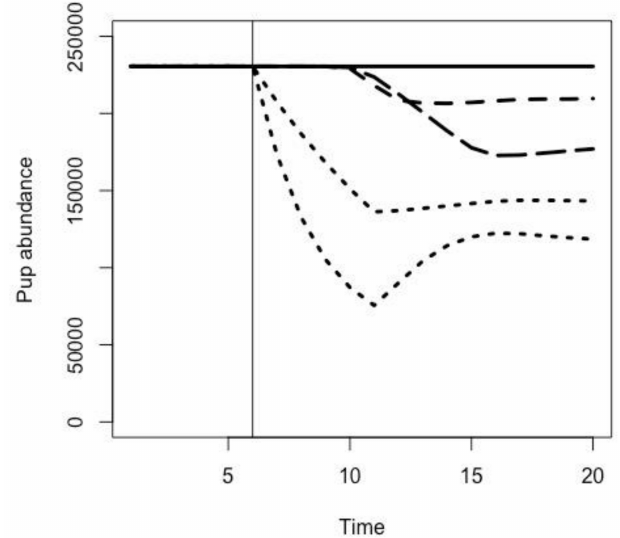
Figure 3. Hypothetical pup abundance projections over a 20-year period under different manipu- lations of Lander’s Leslie matrix [5] for northern fur seals. The horizonal line at the top shows the projection of annual pup births with no manipulation. For all other curves, there was a change in year 6 (shown by vertical line). The two dotted lines show projections if adult seal survival is reduced by 10% and by 50% for five years. The curve with short dashes shows the effect of the complete loss of one year class of pups. The curve with long dashes show the projection if the first-year survival of pups is reduced by 50% for five years. At the end of these perturbations survivals are modeled to return to equilibrium values. Note that reduced adult survival has an immediate effect on pup births, whereas reduced pup survival has a lagged effect on pup